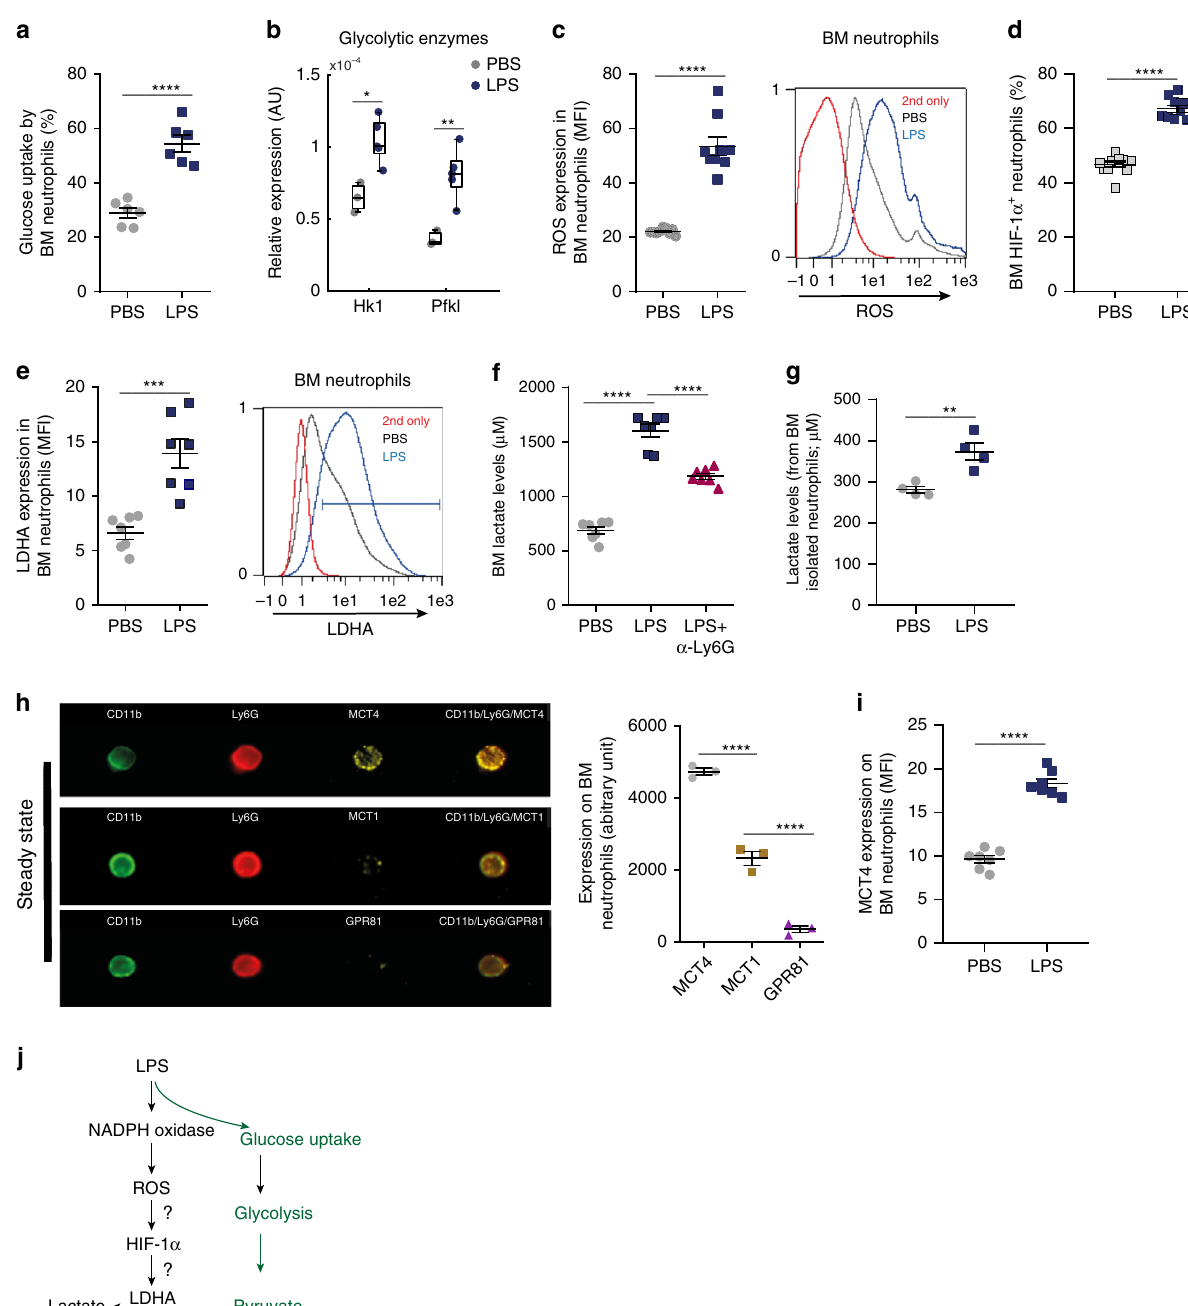
Fig. 1 LPS increases glycolysis as well as lactate production by BM neutrophils. a Flow cytometry quantitative analysis of 2-NBDG-glucose uptake by BM neutrophils (CD11b high Ly6G high cells; n = 6) 4 h following i.p. administration of LPS in vivo in wild-type (WT) mice. b Gene expression of glycolytic enzymes in sorted BM neutrophils from WT mice following LPS treatment ( n = 3, PBS; n = 5, LPS). On each box, the bottom, middle, and the top edges indicate the 25th, 50th, and 75th percentiles, respectively. The whiskers extend to the most extreme data points. c Quantitative analysis and representative histogram plot showing mean fl uorescent intensity (MFI) of ROS production in BM neutrophils following LPS administration ( n = 9). d Percentage of HIF-1 α + neutrophils in the BM following LPS administration ( n = 11). e Quantitative analysis and representative histogram plot of LDHA expression in BM neutrophils following LPS treatment ( n = 7). *** p (0.0003). f BM lactate levels in WT mice treated with PBS, LPS, or LPS followed by α -Ly6G Ab ( n = 7). g Lactate levels released from isolated BM neutrophils treated ex vivo with PBS or LPS (120 ng/ml; n = 4 mice).** p (0.0063). h MCT4, MCT1, and GPR81 (yellow) distribution on BM CD11b + (green)/Ly6G + (red) neutrophils visualized and quanti fi ed by ImageStream analysis. Images are from one representative experiment out of three. Scale bar indicates 7 μ m. i Quantitative analysis of MCT4 expression on BM neutrophils 4 h following LPS administration ( n = 7). j A scheme of the proposed mode of action of LPS in lactate production by BM neutrophils. Data are represented as mean ±